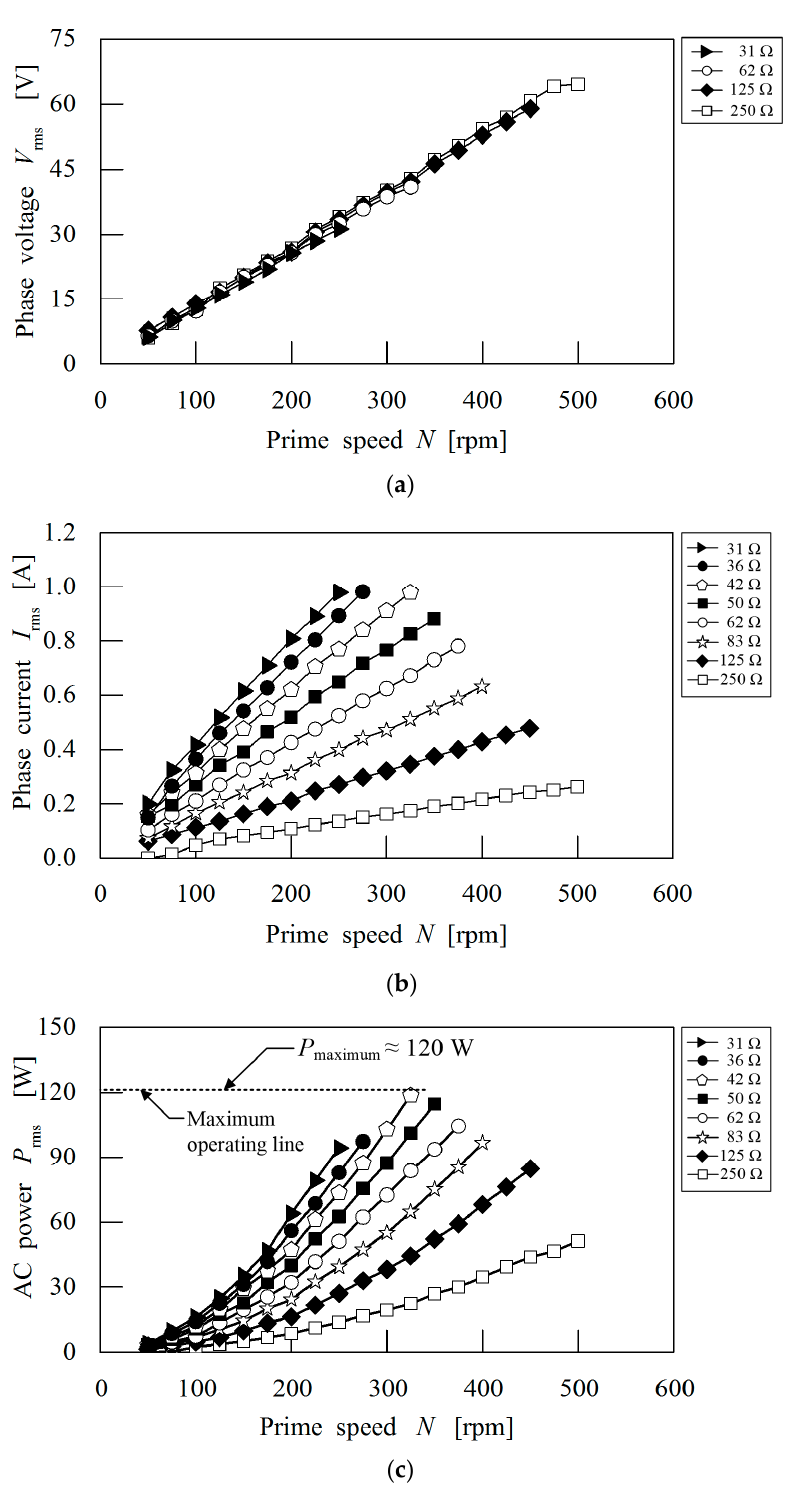
Figure 14. Measured AC voltage/current/power vs. speed characteristics at various loads: ( a ) RMS voltage vs. speed; ( b ) RMS current vs. speed; ( c ) Active power vs. speed.